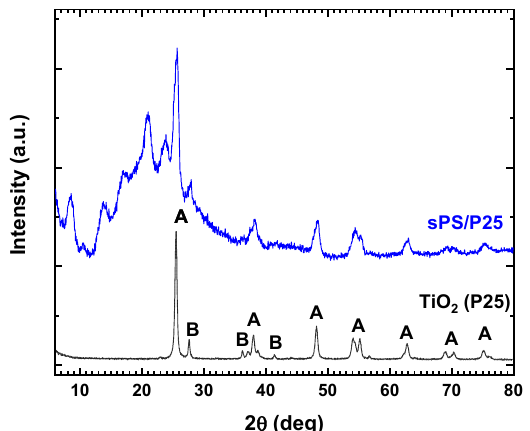
Figure 1. X-ray diffraction patterns of commercial TiO 2 (P25) and sPS/P25 aerogel. A: anatase phase; B: rutile phase.